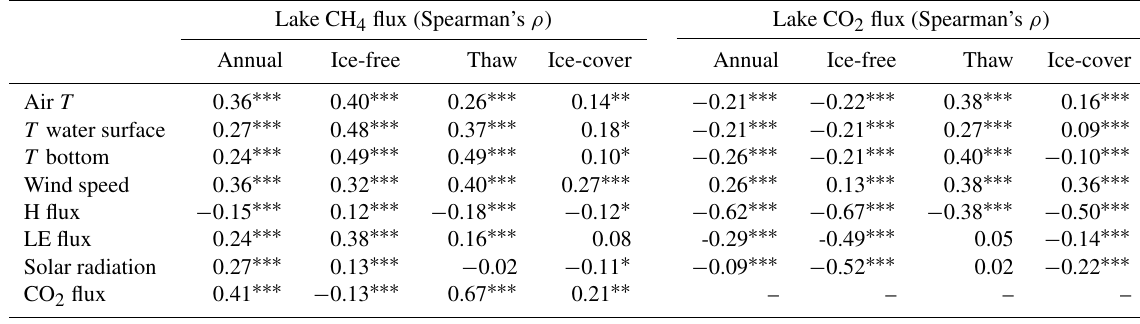
Table 2. Statistical exploration of the lake flux dataset: Spearman’s rank correlation coefficient ( ρ) shows the degree of association between half-hourly lake CH 4 flux and lake CO 2 flux with potential drivers of variability. All data were grouped per season. See Table 1 for the limitation of the seasons. Lake fluxes are filtered in winter for high standard deviation of lateral wind speed.